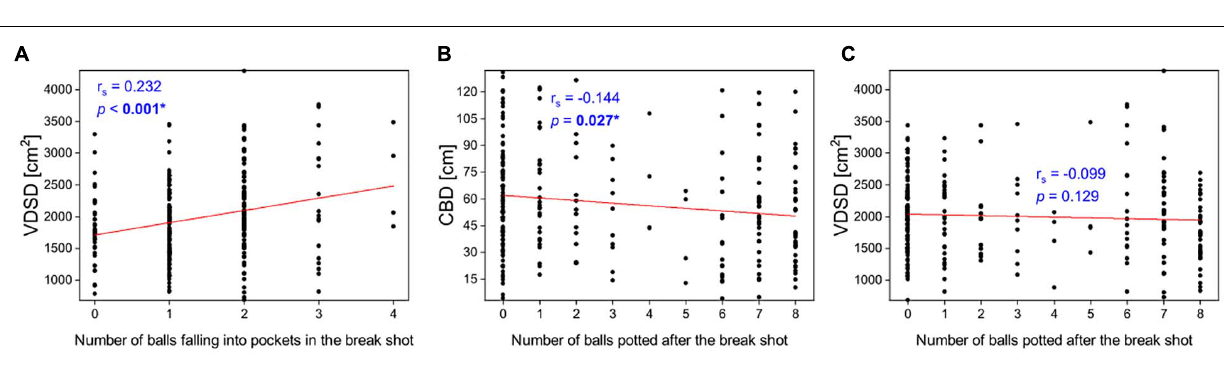
FIGURE 3 | (A) Correlations between the number of balls falling into pockets in the break shot and SDVD. Correlations between the number of balls potted after the break shot and (B) CBD and (C) SDVD. CBD denotes the distance between the end position of the cue ball and the center of the pool table; SDVD denotes the standard deviation of the areas of all the Voronoi diagram cells. Significant difference ( p < 0.05) is shown in bold text and indicated by an asterisk. TABLE 1 | Binary analysis of the two predictors of the break shot characteristics for the game outcomes in 9-ball. Clear or not Win or not Predictors χ 2 OR (95%